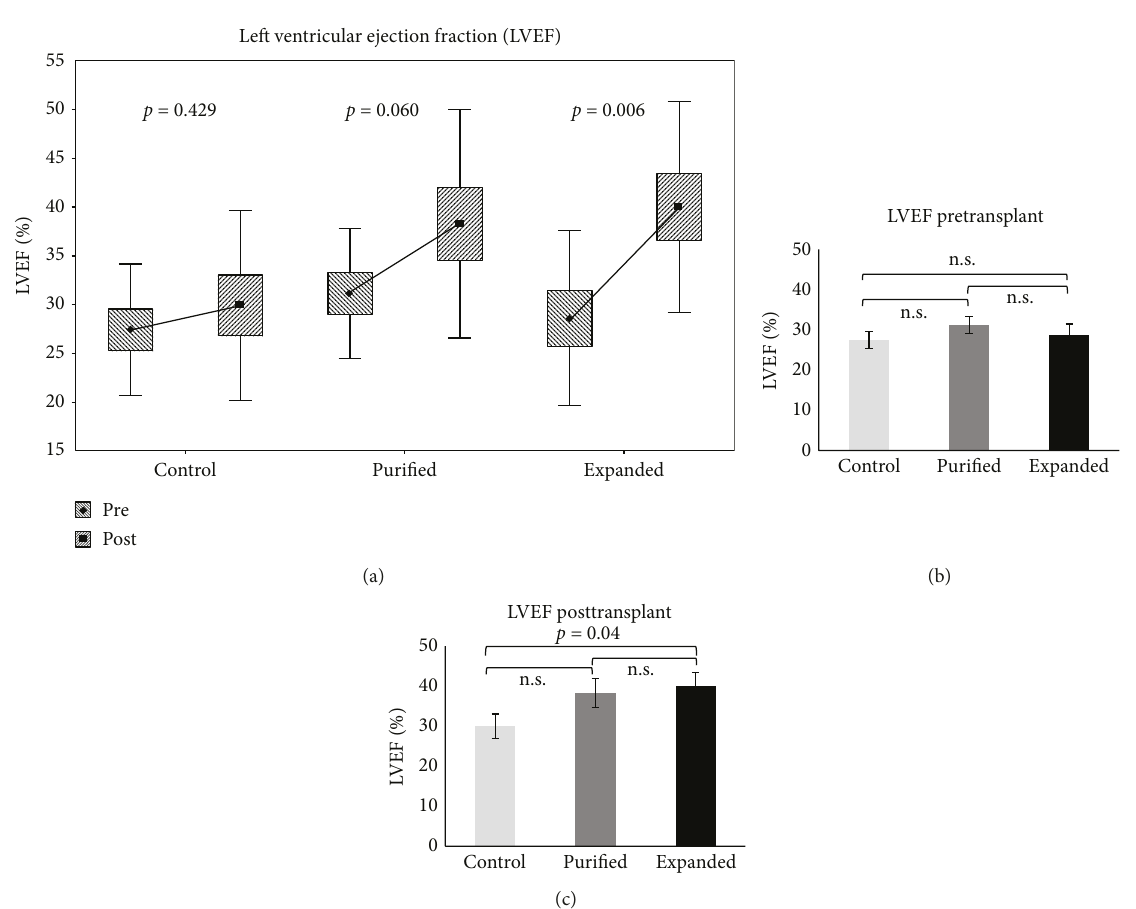
Figure 3: The ejection fraction of the animals with AMI signi fi cantly increased after transplantation with expanded CD133 + cells. Comparison of the left ventricle ejection fraction within each group (a) and among the groups before (b) and after transplantation (c). Control=control group, injected with isotonic saline solution (sodium chloride 0.9%). Puri fi ed=transplanted with puri fi ed CD133 + cells. Expanded =transplanted with expanded CD133 + cells. The p value is shown for each